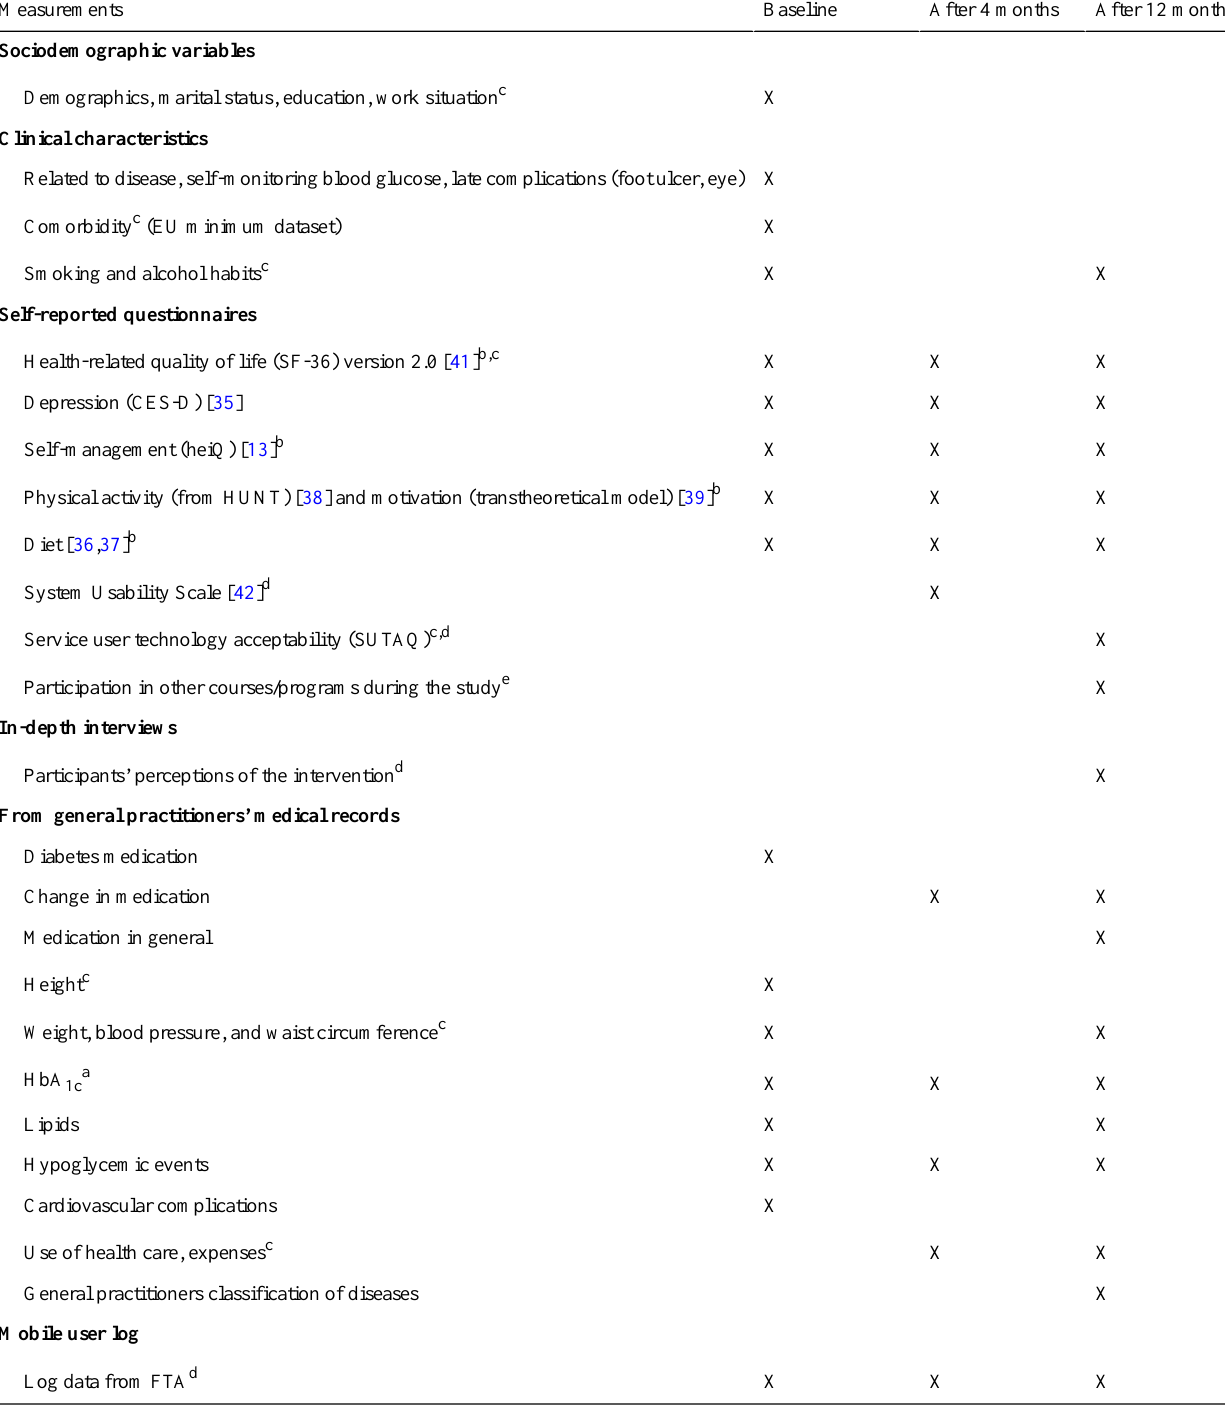
After 12 monthsAfter 4